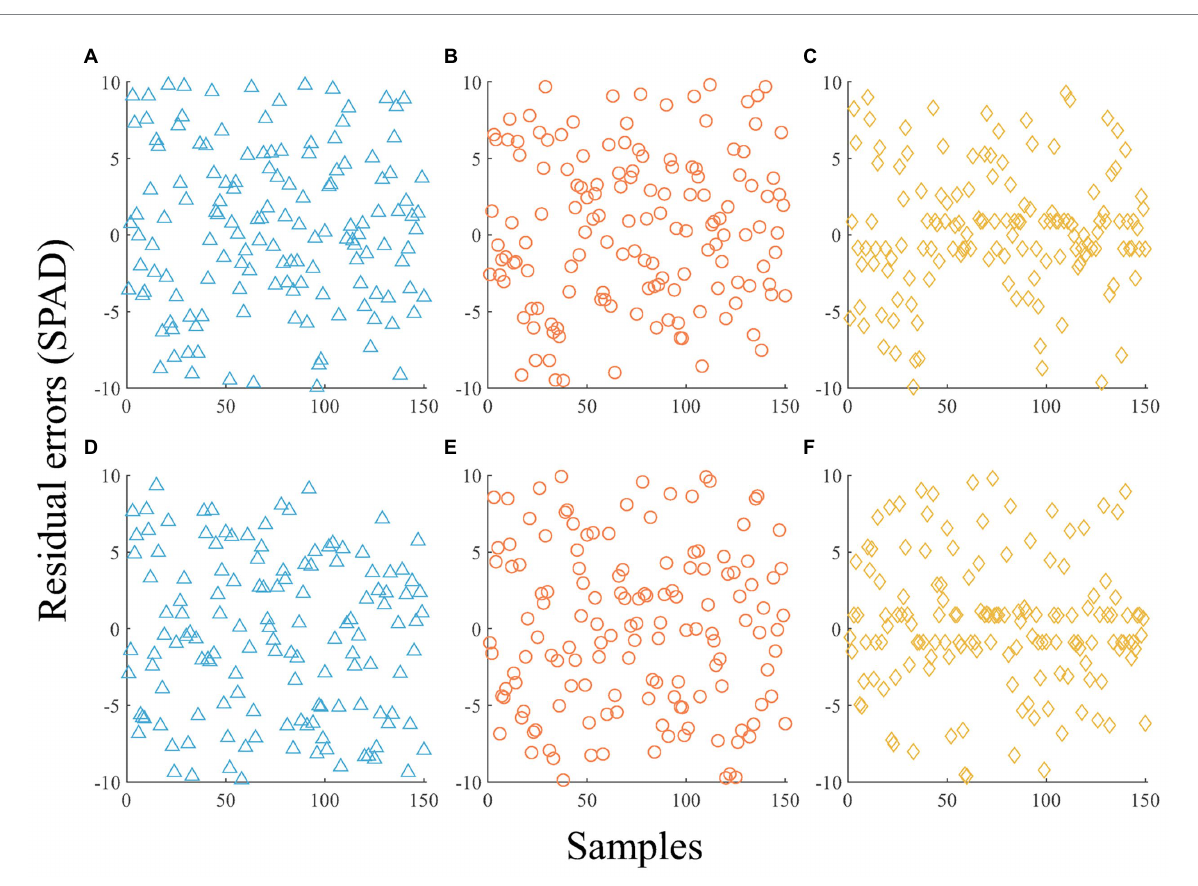
TABLE 7 Evaluation of the OLR, RF, and SVR models without shade variables.